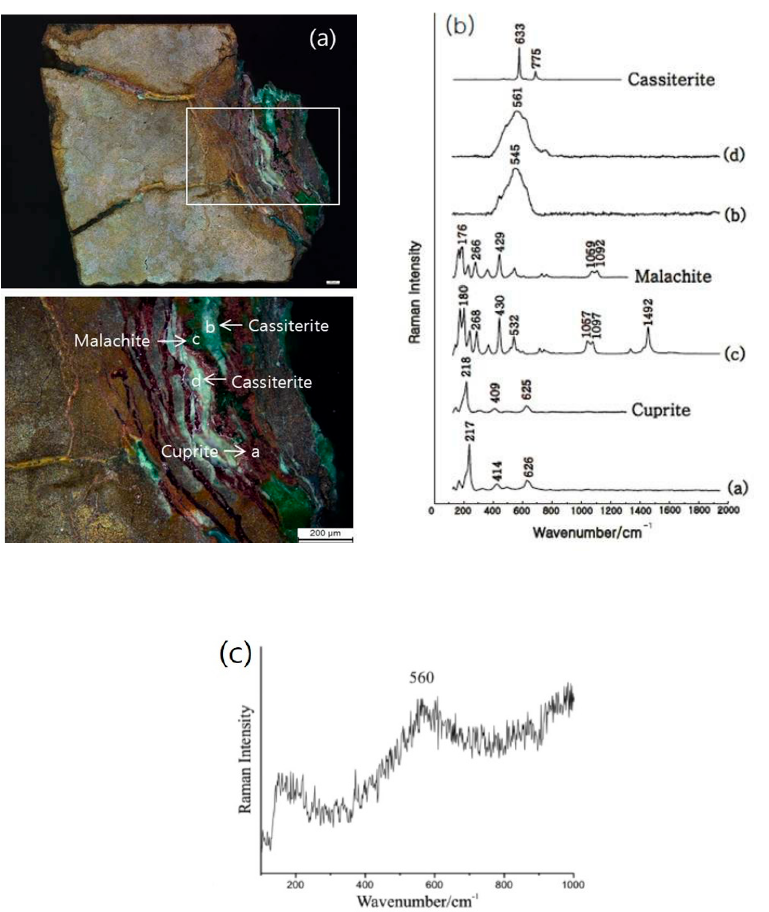
Figure 4. ( a ) Ga-2 (No. 1) corrosion layer darkfield (DF) images, ( b ) Raman spectrum, and ( c ) Raman spectrum of nanocrystalline SnO 2 . EPMA analysis found that Sn content increased significantly toward the edges’ cor- rosion layers, which contained SnO 2 (Figure 5). Excluding highly reducing environments